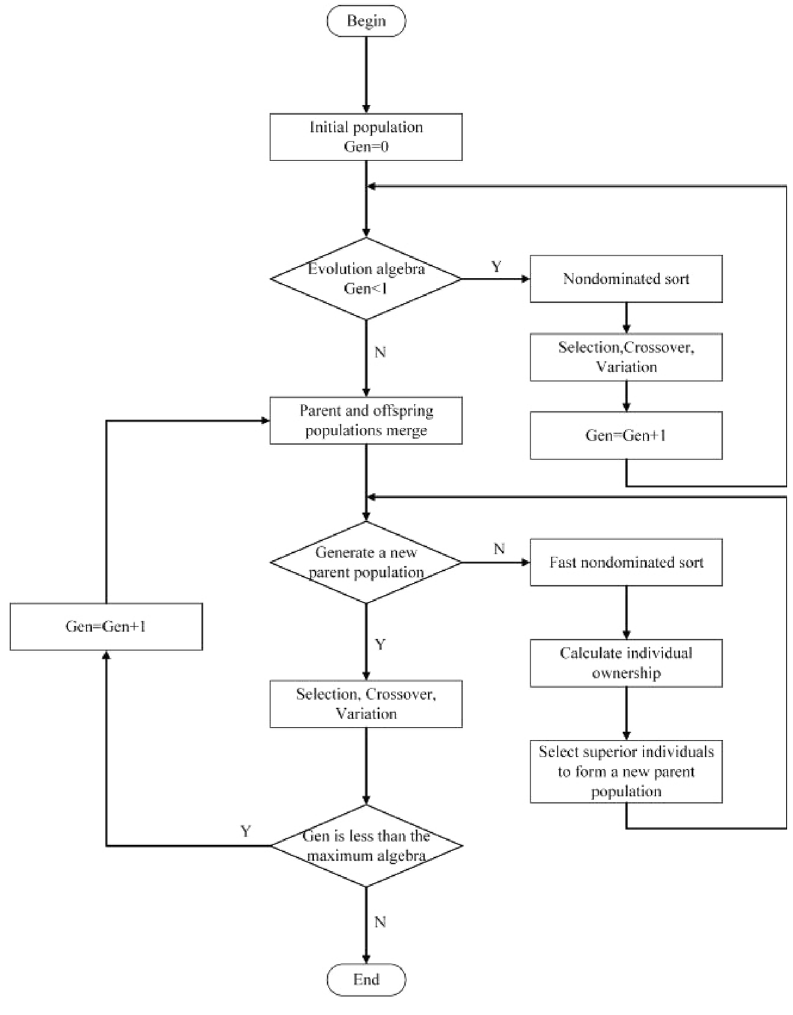
Figure 24. NSGA-II algorithm flow